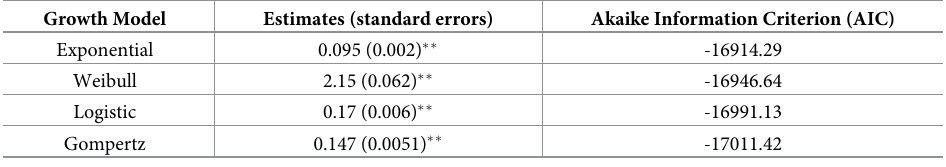
Table 1. Estimates of different parameter